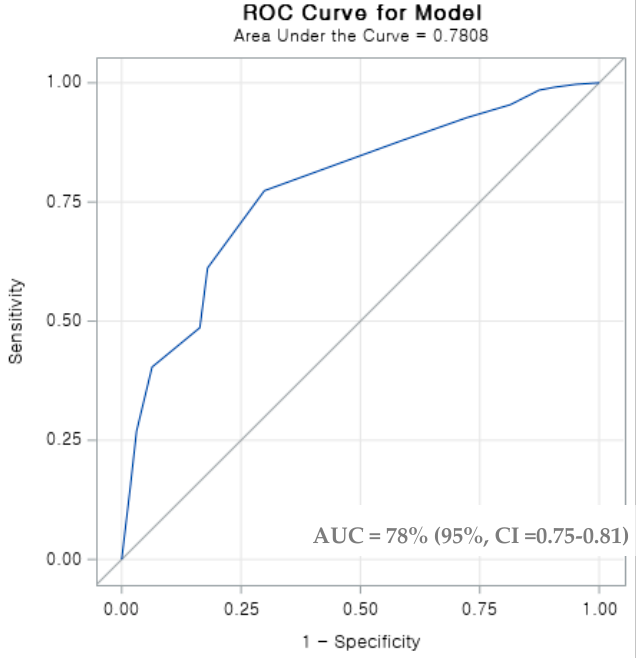
Figure 2. Receiver operating characteristic (ROC) curve for the LACE index in hospitalized AMI patients. The ROC curve illustrates the LACE index predictions of a high risk of 30-day readmission at different cut-off points with increased sensitivity and decreased specificity. The area under the curve (AUC), which is equal to the C-statistic (0.78), indicates a favorable model to predict the risk of a 30-day readmission in patients with AMI.